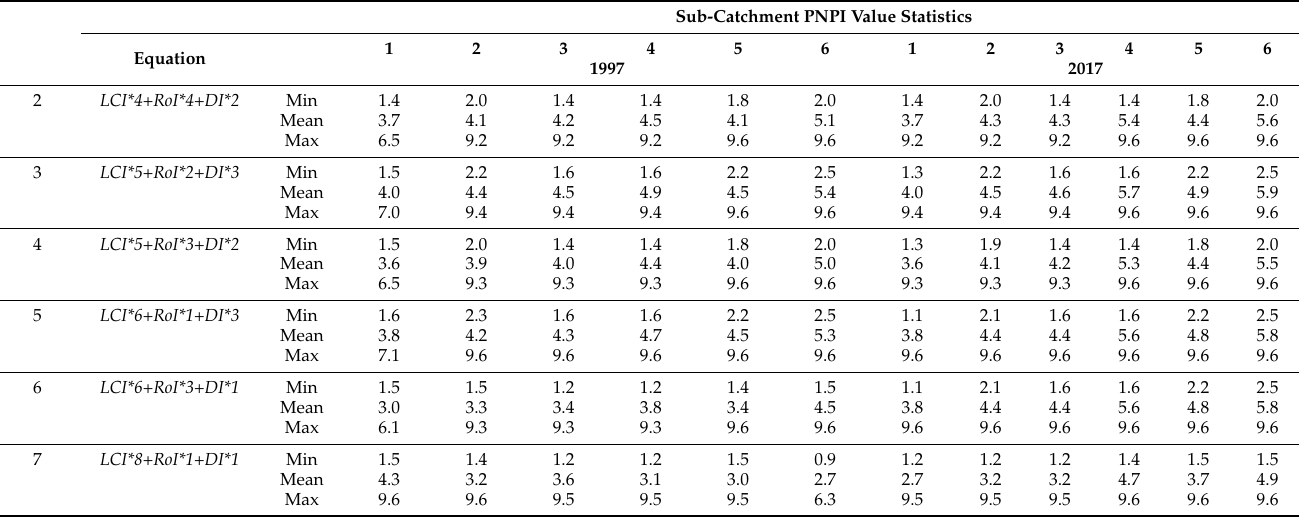
Table 7. Statistics on non-point pollution index (PNPI) values obtained for sub-catchments 1–6 within 1997 and 2017 on using Equations (2)–(7).